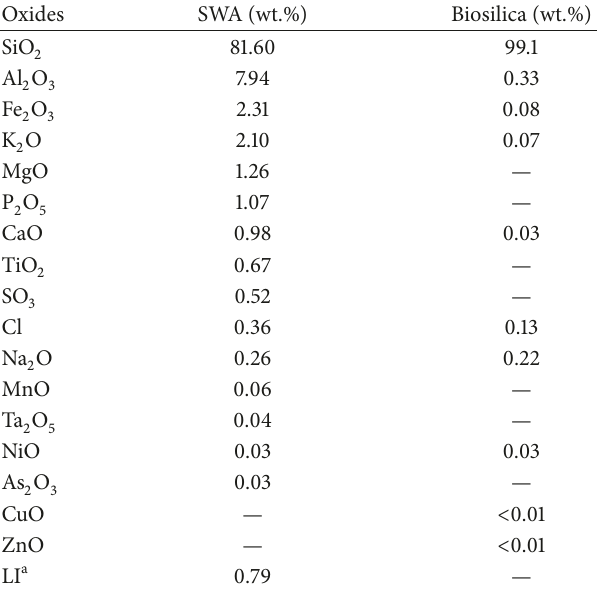
Table 2: Chemical composition of sugarcane waste ash and synthe- sized biosilica.